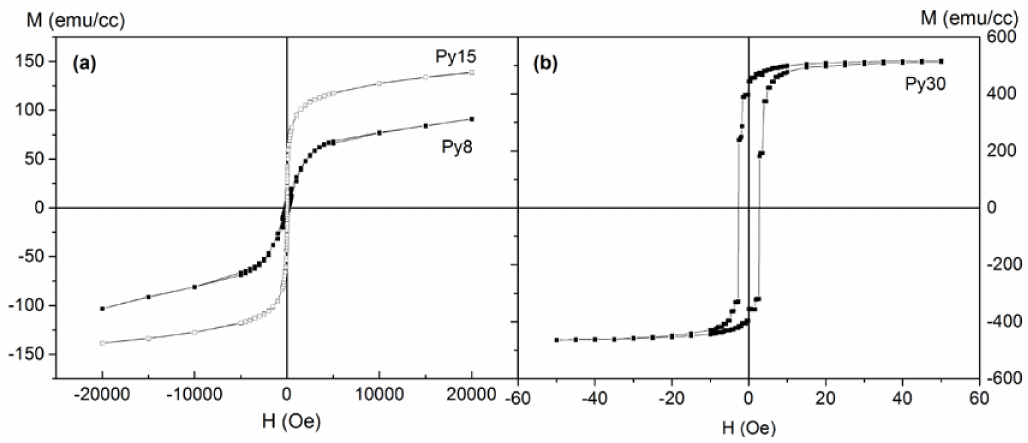
Figure 4. Hysteresis loops obtained at 5 K for the samples Py8 and Py15 ( a ) and for Py30 ( b ).